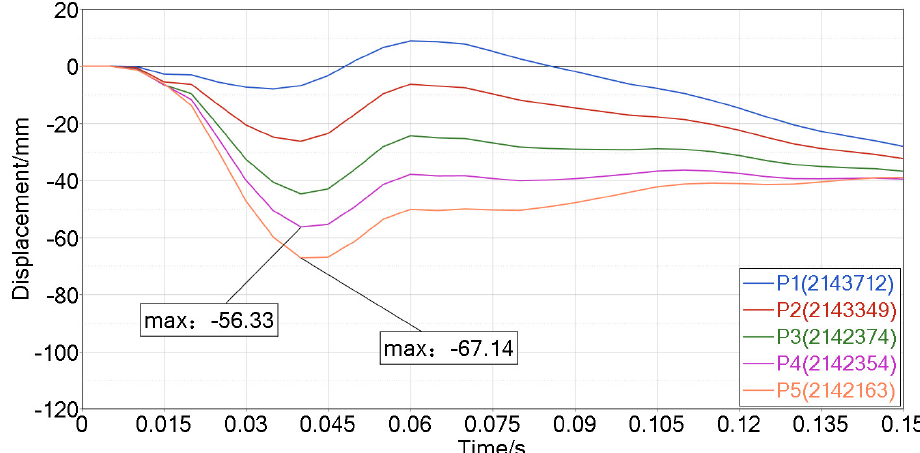
Figure 18. Amount of intrusion at each point of the B-pillar inner